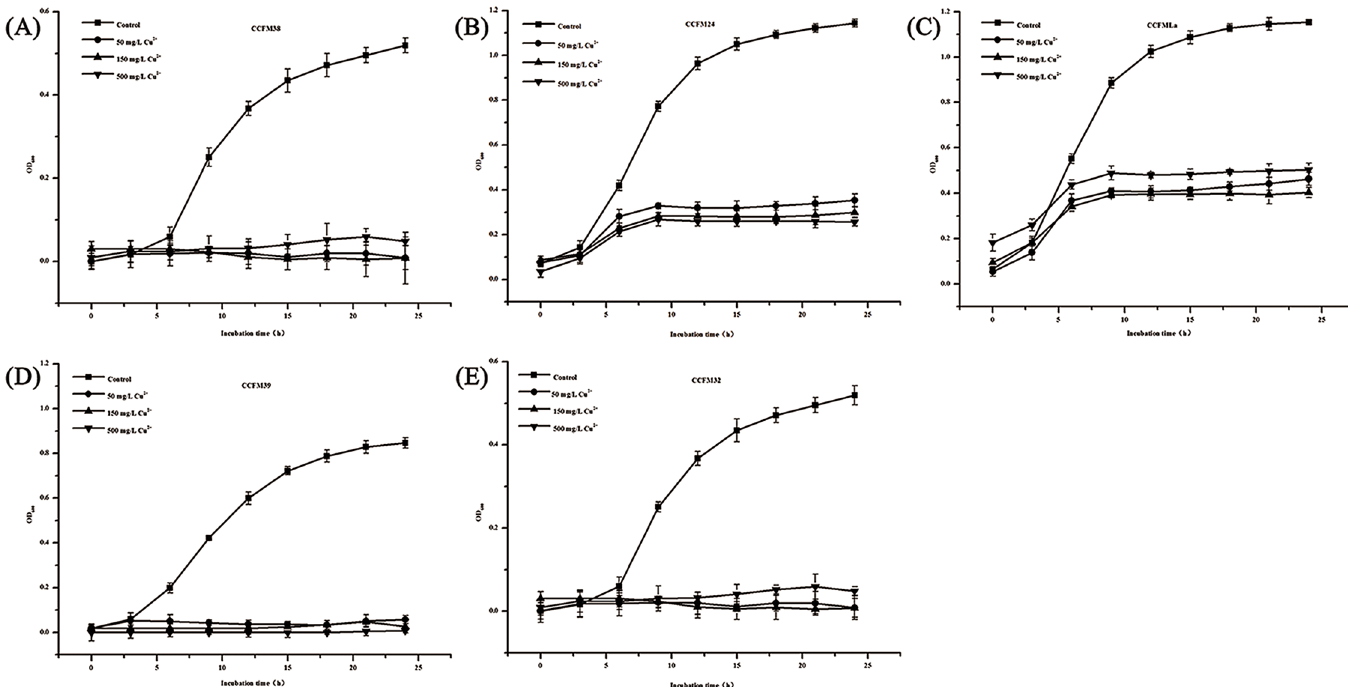
Fig 2. The first kind of growth of strains in different copper ion MRS broths. The subgraphs (A) to (E) show the tolerance ability of CCFM38, CCFM24, CCFMLa, CCFM39 and CCFM32,